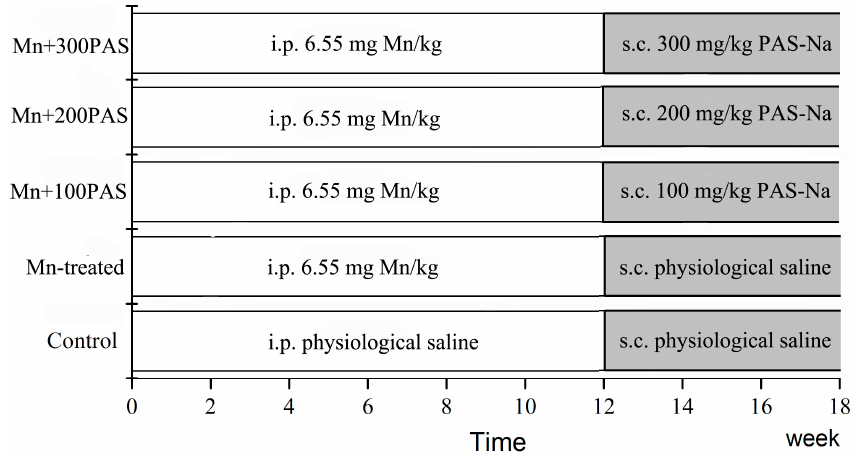
Figure 1. Experimental design.